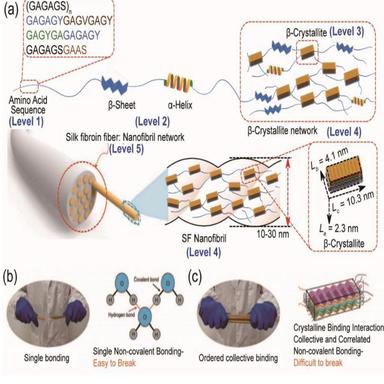
Schematic illustration of the 5 levels structures within SF materials. Level 1: Amino acid sequence; level 2: α-helix and β-sheet. These are stabilized by intermolecular H-bonds, and β-sheets are formed via crystallization; level 3: β-crystallites. The formation is attributed to the inter-sheet interactions, and several neighboring β-sheets (from different molecules) can crystallize into intermolecular β-crystallites; level 4: Crystal network. It is composed of numerous β-crystallites, which are connected t